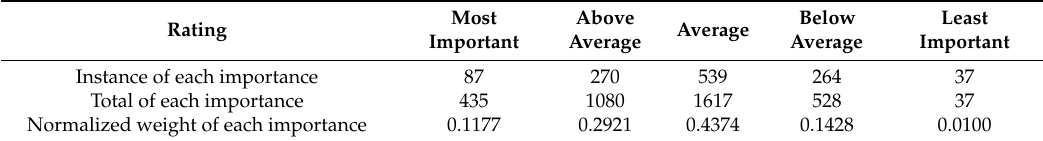
Table 20. Weightage of Rating.